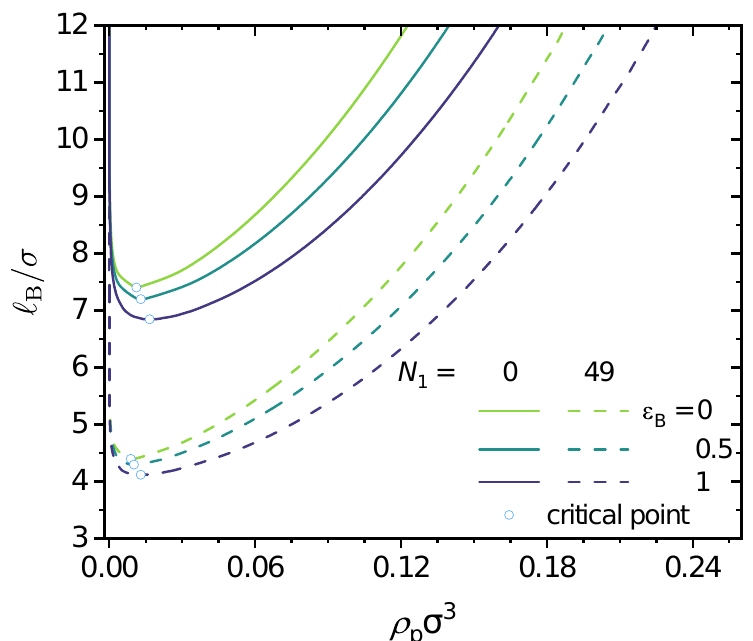
Figure 5. Predicted binodal curves from the GUI App presented in this work. The values for the following parameters were fixed: N T = 100, η = 0.5, (cid:101) AC = (cid:101) A = 0, Z A = − 1, Z C = + 1. Values for N 1 and (cid:101) B were varied, as shown in the figure. Critical points are shown as open circles.